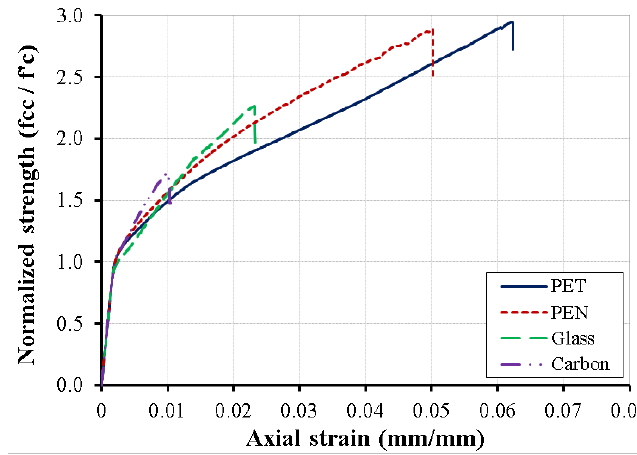
/𝑓 𝑐′ ) relationship for PET, PEN, Glass, and 𝑐𝑐